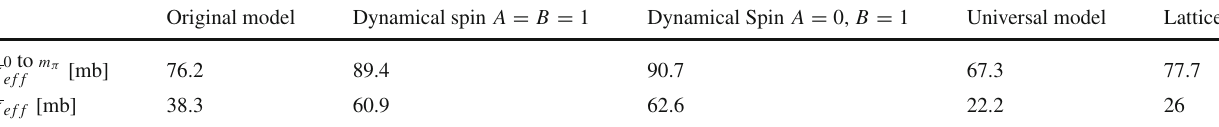
Table 3 Values of σ ef f obtained within different pion models and the lattice approach, by taking into account only geometrical effects. In the first row σ ef f has been evaluated by performing the integral in Eq. (17)